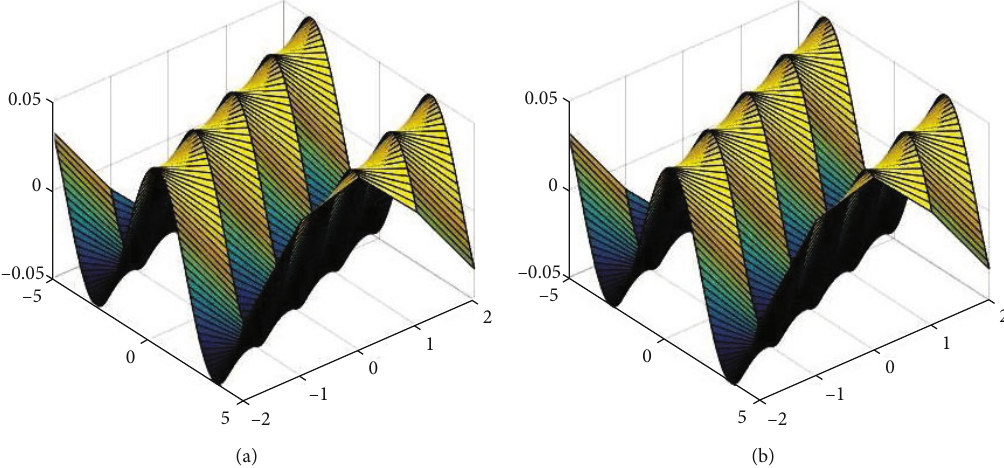
Figure 1: (a) Actual and (b) SDM/q-HATM result of μ ð χ , ξ , I Þ at δ = 1 .